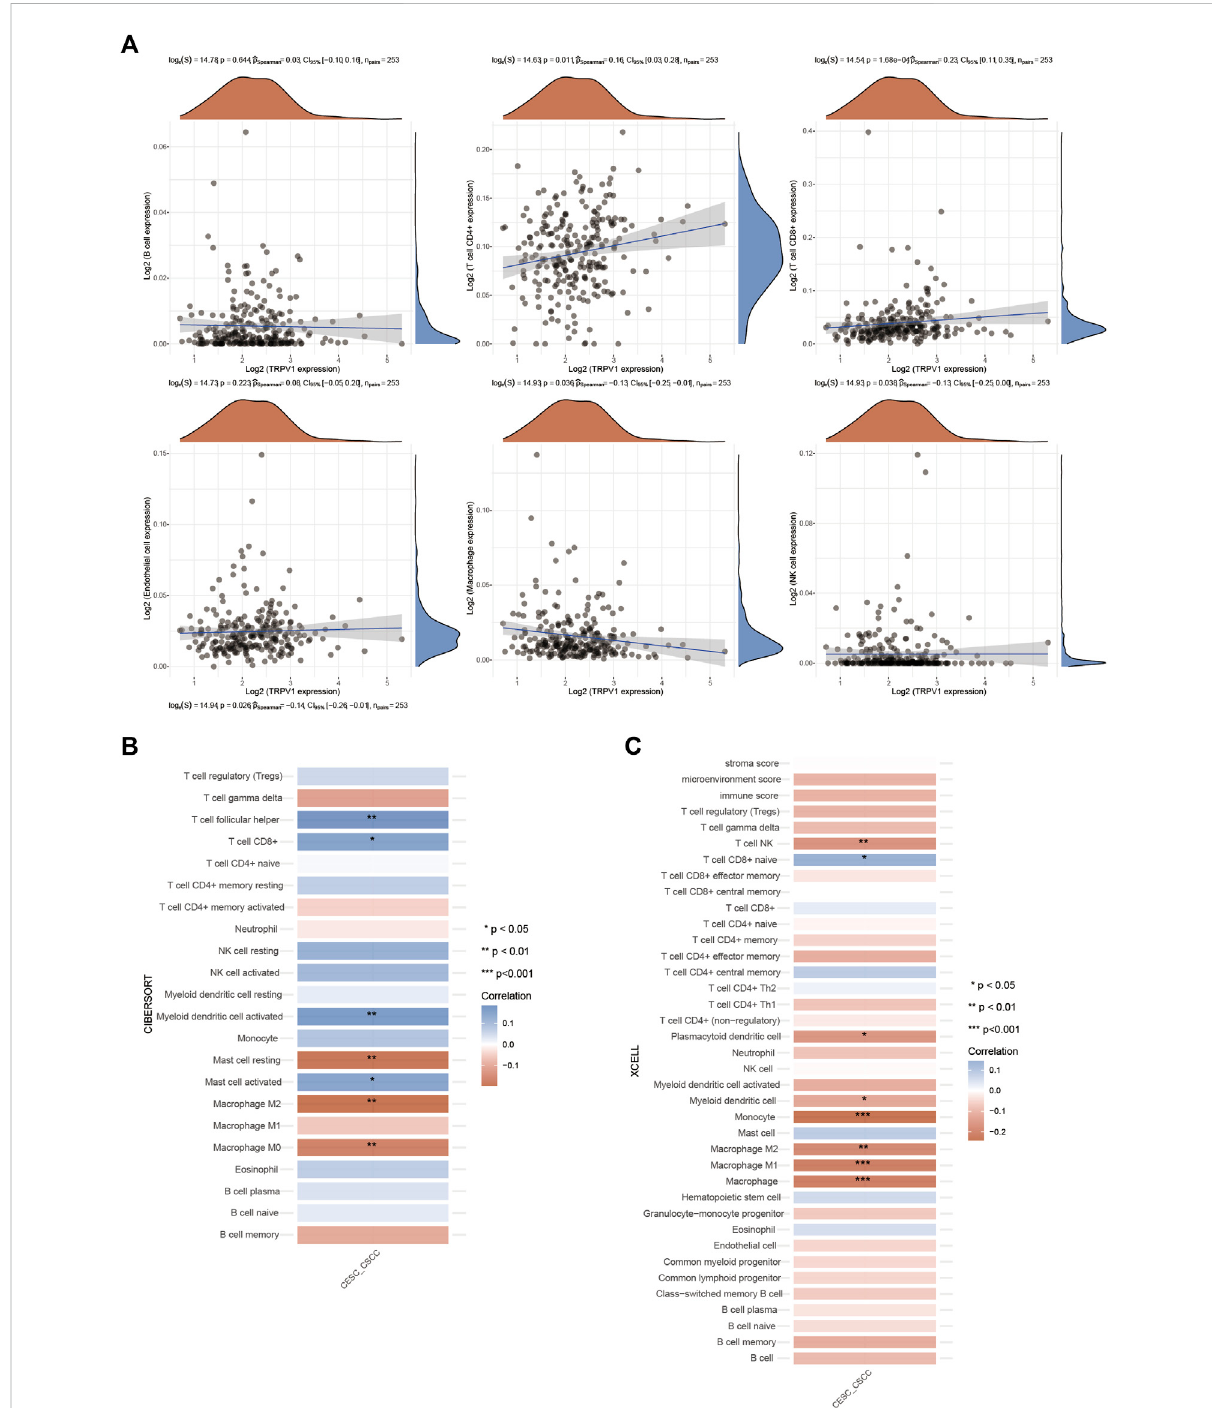
FIGURE 6 RegulationofTRPV1onimmunein fi ltratingcellsinCSCC. (A) ThecorrelationsbetweenTRPV1expressionandimmunescorewasanalyzedwith Spearman. The abscissa represents the distribution of the gene expression or the score, and the ordinate represents the distribution of the immune score. The density curve on the right represents the trend in distribution of the immune score, the upper density curve represents the trend in distributionof thegene expression or the score. The value on the top represents thecorrelation p value, correlation coef fi cient and correlation calculation method. (B,C) The correlations among TRPV1 with CIBERSORT and XCELL methods: A heatmap of the correlation between TRPV1 and immune score. ** for p < 0.01, * for p <